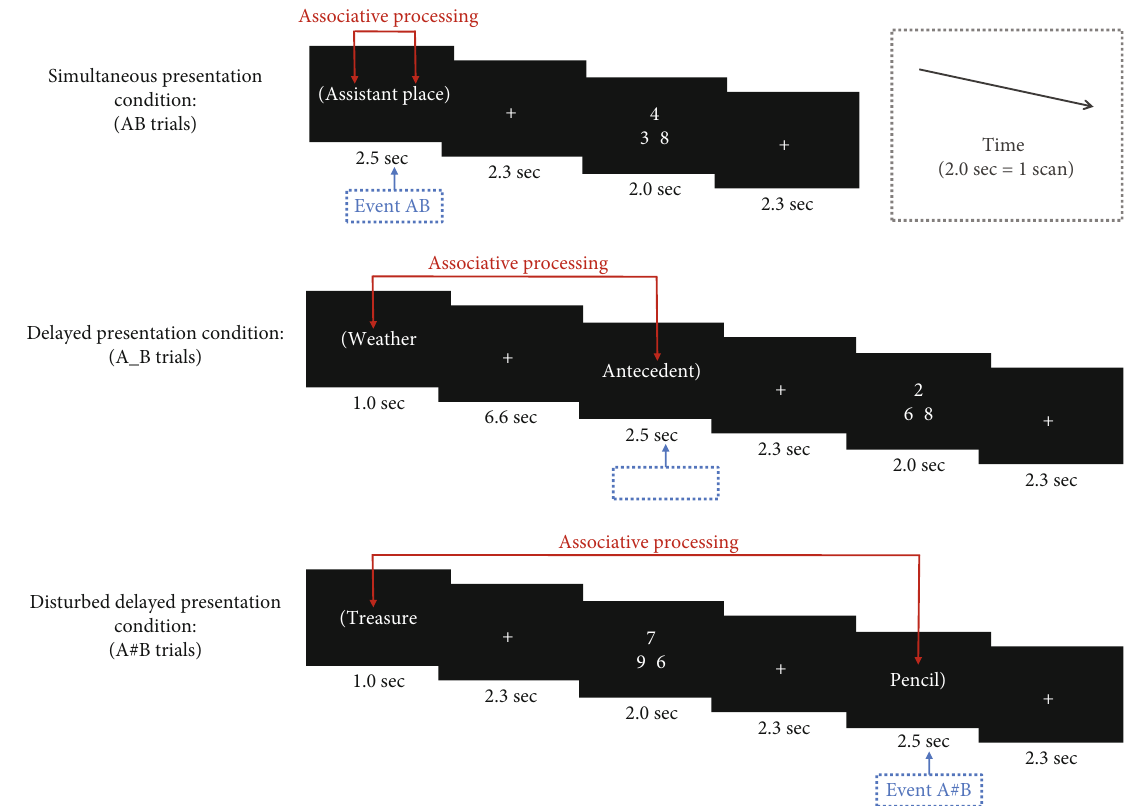
Figure 1: Examples of di ff erent type of trials. Notice that each pair of to-be-judged words was included in parentheses in order to avoid confusion between